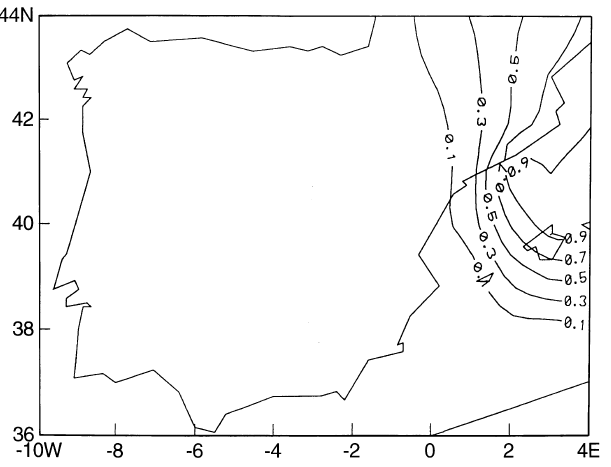
Fig. 7. Diabatic heating at 700 hPa for 1200 UTC 15 March 1990. Contour interval is 2 (cid:2) 10 (cid:255) 17 hPa (cid:255) 1 s (cid:255)